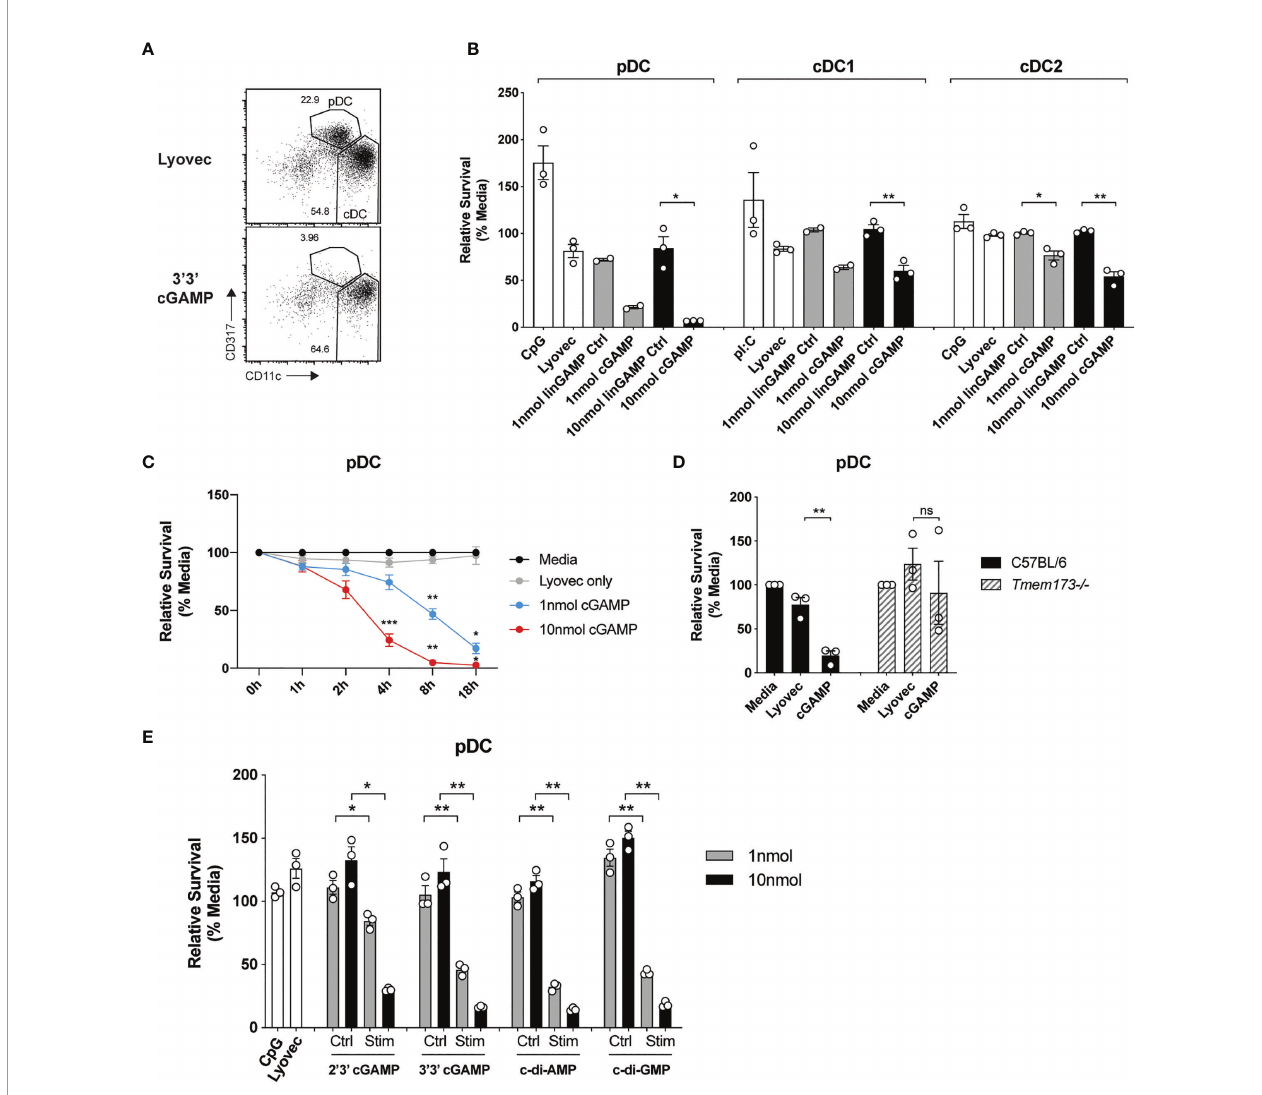
FIGURE 3 | cGAMP stimulation induces rapid, potent killing of mouse pDCs. (A) FACS plots showing bulk mouse splenic pDCs (CD11c int CD317 hi ) and cDCs (CD11c hi CD317 lo ) stimulated for 18 h with 10 nmol 3 ’ 3 ’ cGAMP complexed with lyovec, or lyovec alone. (B) Sorted mouse splenic pDCs and cDC subsets from a pool of 15-17 mice were stimulated for 18 h with 1 or 10 nmol 3 ’ 3 ’ cGAMP, its linearized control ligand (linGAMP Ctrl) complexed with lyovec, lyovec alone, 0.5 m M CpG2216 or 100 m g/mL pI:C. Bar graphs show the mean relative survival (compared to media alone) ± SEM compiled from 2-3 independent experiments. (C) Bulk splenic DCs from a pool of 5-6 mice per replicate were stimulated with 1 or 10 nmol 3 ’ 3 ’ cGAMP complexed with lyovec or lyovec alone for the indicated time points. Line graph depicts the mean relative survival (compared to media alone) ± SEM combined from 3 independent experiments. (D) Bulk splenic DCs from C57BL/6 or Tmem173 -/- mice were stimulated with 10 nmol 3 ’ 3 ’ cGAMP complexed with lyovec or lyovec alone for 18 h. Bar graphs show their mean pDC relative survival ± SEM from 3 individual mice per genotype. (E) Bulk splenic DCs were stimulated with 1 or 10nmol 2 ’ 3 ’ cGAMP, 3 ’ 3 ’ cGAMP, c-di-AMP or c-di-GMP complexed with lyovec, their respective linearized control ligands (Ctrl) complexed with lyovec, lyovec alone or 0.5 m M CpG2216 for 18 h. Bar graphs represent the mean relative survival of pDCs ± SEM from 3 biological replicates (pool of 2 mice per replicate). Statistical analyses were performed using (B, D, E) two-tailed Paired Student ’ s t test or (C) two-way ANOVA using Tukey ’ s test to correct for multiple comparisons where *P < 0.05, **P < 0.01, ** *P < 0.001 and ns, not signi fi